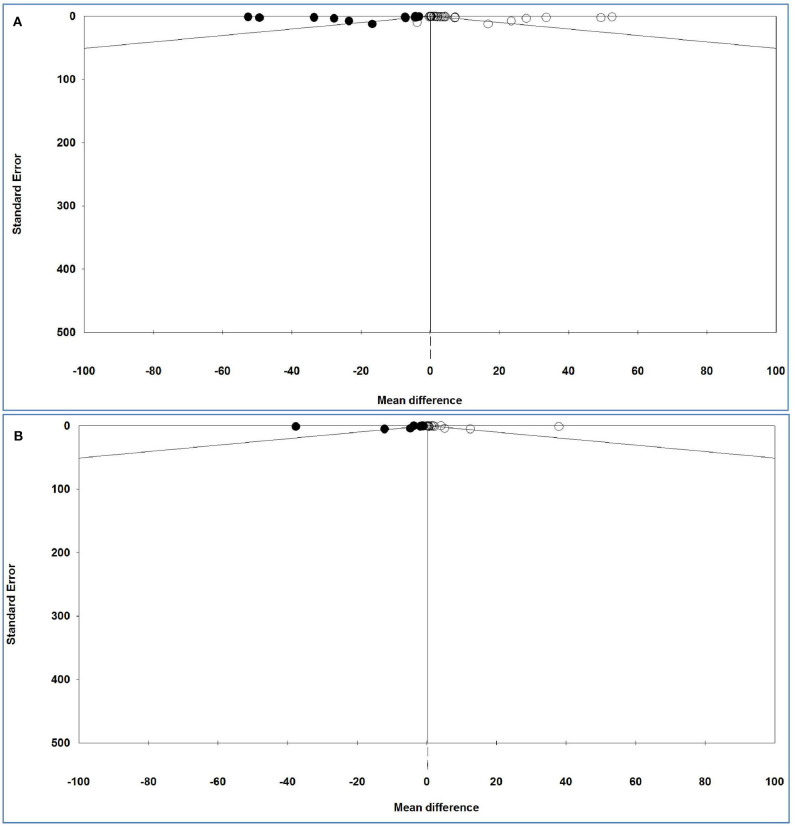
Funnel plot of analysis of interleukin-6 levels in adult participants on (A) serum and (B) plasma in adult participants. Open circles represent observed studies. Black circles represent imputed studies. Open diamonds represent the pooled effects from the original studies. Black diamonds represent the pooled effects incorporating the imputed studies.